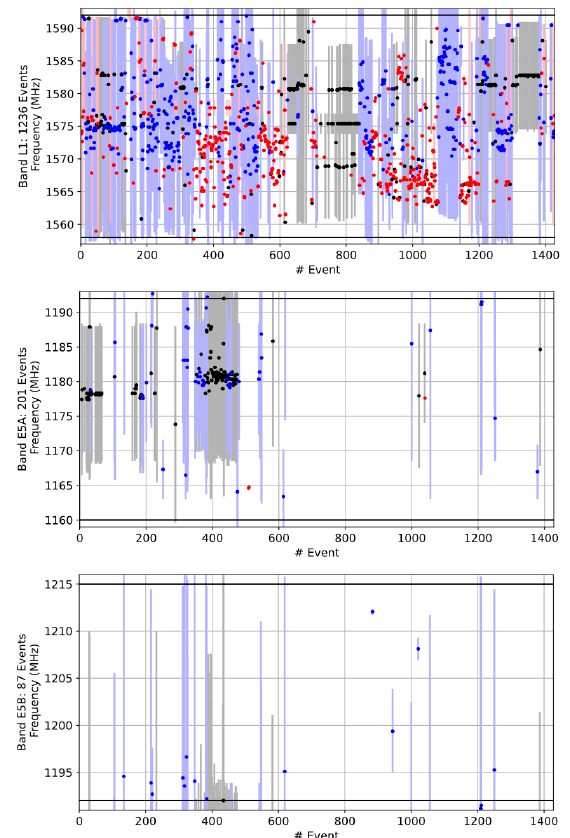
Figure 7. Band occupancy, Amsterdam station, Netherlands, 2020. Events that occur at the same time at different bands are given the same event number. The center frequency of each event is marked with a dot and the bandwidth with a vertical line. Narrowband events are indicated with red, wideband black and time-modulated blue. Black horizontal lines indicate the band limits.